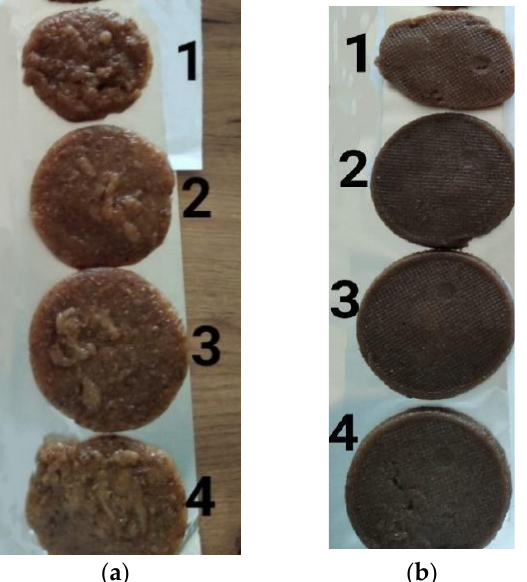
Figure 1. Visual appearance of ( a ) Samples 1, 2, 3, and 4 before solar drying, and ( b ) Samples 1, 2, 3, and 4 after solar drying.